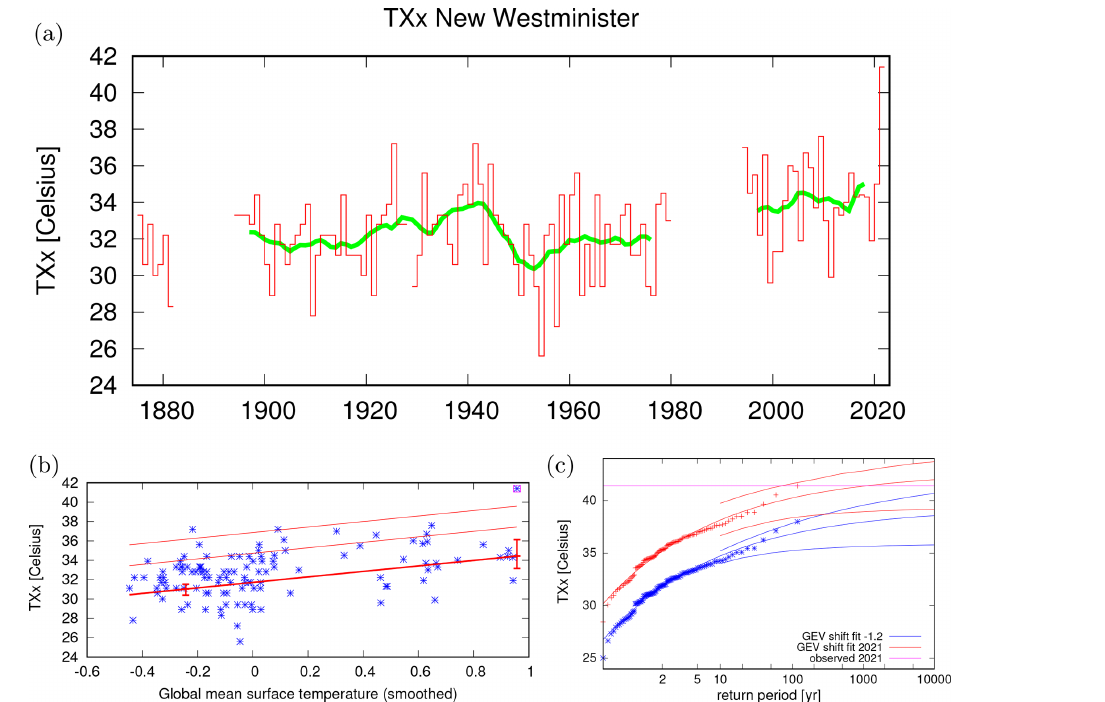
Figure 11. As Fig. 9 but for the station data at New Westminster. Data source: AHCCD (Vincent et al.,